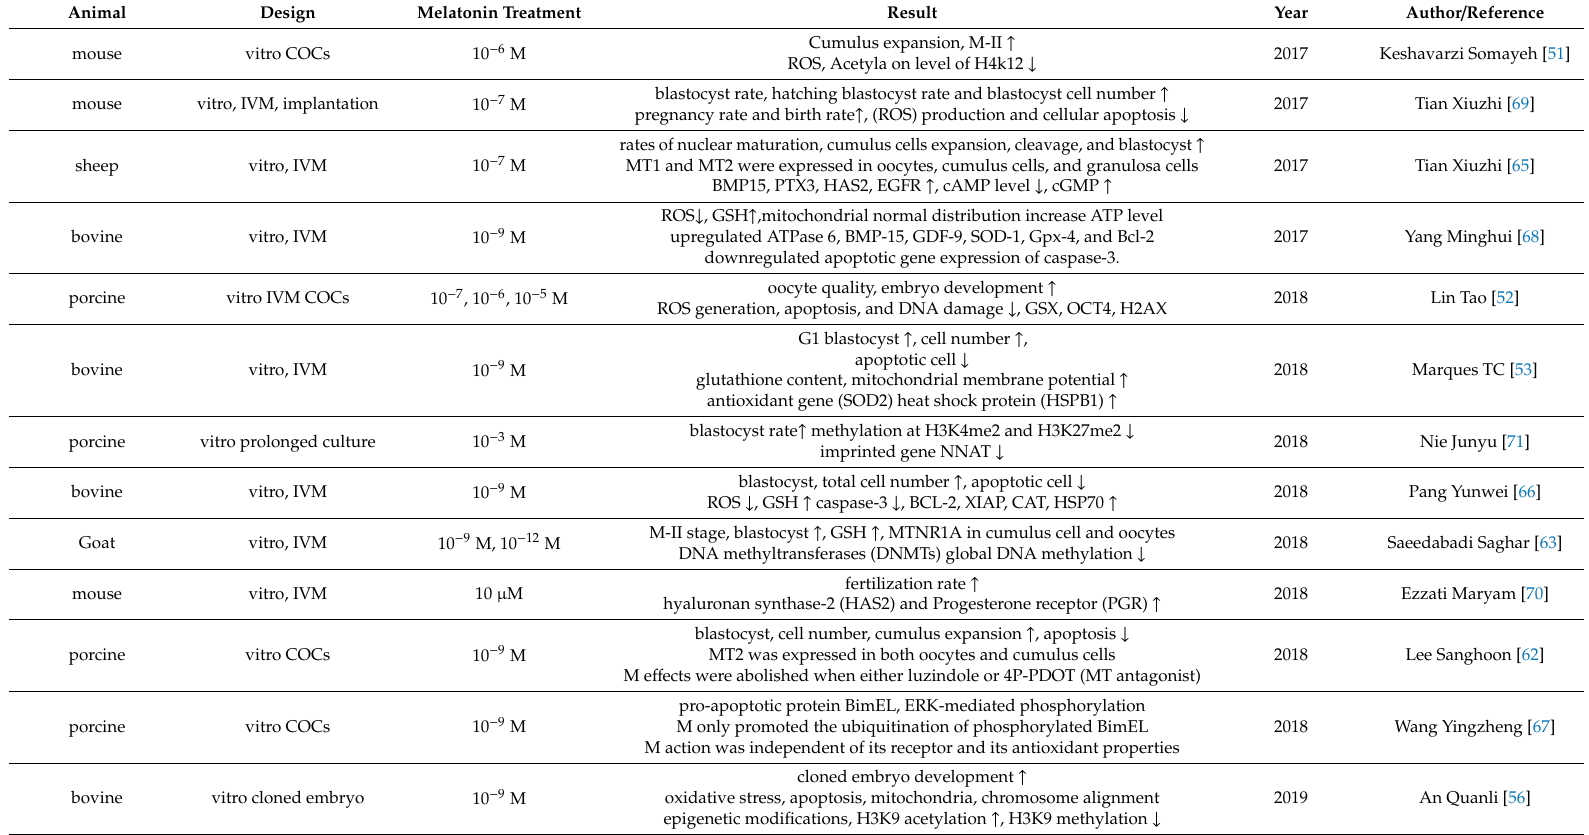
Table 2. E ff ects of melatonin on assisted reproductive technology under in vitro conditions. COC: cumulus oocyte complex; IVM: in vitro maturation; M II: metaphase II; ROS: reactive oxygen species; MT1, MT2: melatonin membrane receptors; BMP: bone morphogenic protein; PTX3: pentraxin-3; HAS2: hyaluronan synthase 2; EGFR: epidermal growth factor receptors; GSH: glutathione; ATP: adenosine triphosphate; GDF: growth di ff erentiation factor; SOD: superoxide dismutase; GPX: glutathione peroxidase; Bcl-2: B-cell lymphoma-2; GSX: reduced glutathione; OCT4: octamer-binding transcription factor 4; H2AX: histone H2 family member X; H3K4me: methylation of lysine4 on histone H3; H4K27me: methylation of lysine27 on histone H3; CAT: catalase; HSP: heat shock protein; MTNR1A: melatonin receptor 1A; MT: melatonin receptor; 4P-PDOT: 4-phenyl-2-propionamidotetralin; BimEL: Bcl-2 interacting mediator of cell death extra-long; ERK: extracellular signal-regulated kinase; H3K9: histone H3 lysine